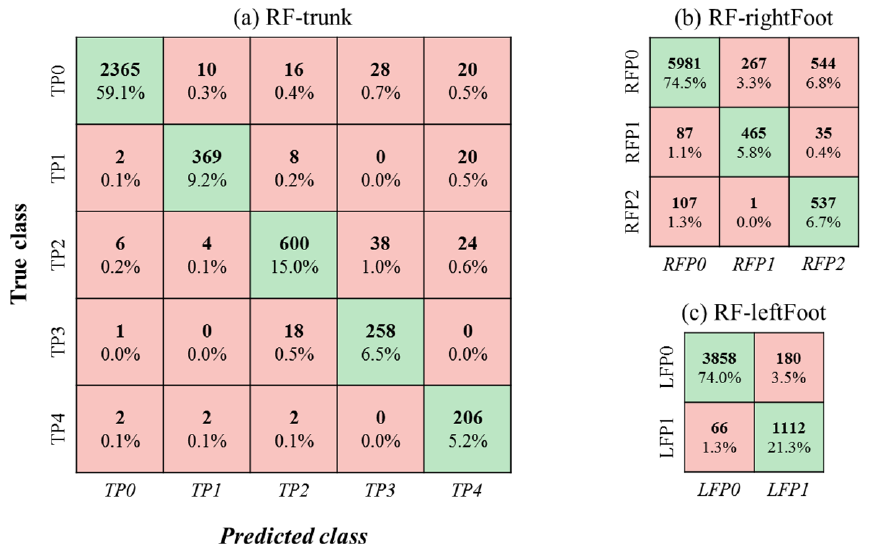
Figure 7. Confusion matrices of three RF classifiers. The green downward diagonal shows the number and proportion of correct detection cases for each class.